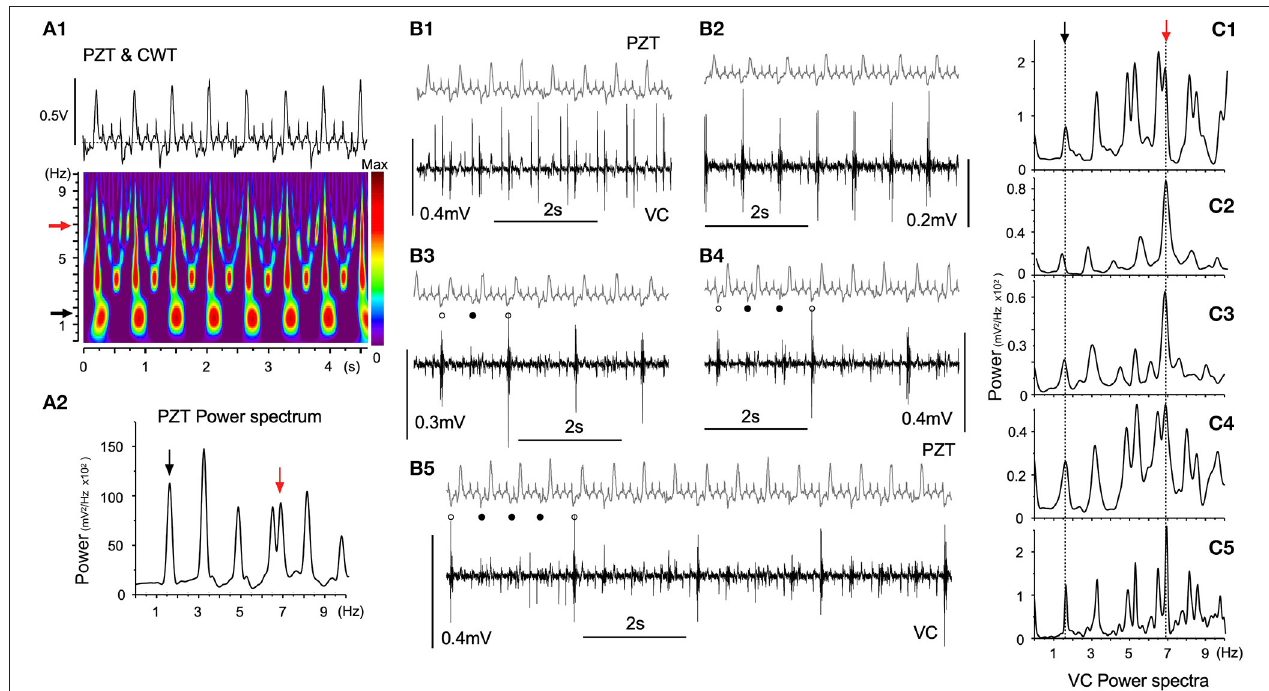
FIGURE 5 | Temporal dynamics of vagal complex (VC) neuronal activities synchronized with cardiorespiratory rhythms. (A) A piezoelectric pulse transducer (PZT) recorded cardiorespiratory rhythmic wave and the time-resolved power spectrum by the continuous wavelet transform (CWT) analysis (A1) . Respiratory (1.65Hz, black arrow) and cardiac (6.97Hz, red arrow) rhythms are shown in the CWT time-resolved power spectrum. (A2) An FFT power spectrum of PZT consists of fundamental respiratory (1.65Hz, black arrow) and cardiac (6.97Hz, red arrow) frequency peaks and several respiratory harmonic peaks. (B) Temporal phase transition of polyphasic high-amplitude potentials occurring in synchrony with every cardiac cycle (B1) , every respiratory cycle (B2) , every second respiratory cycle ( B3 , open and solid dots), every third respiratory cycle ( B4 , open and solid dots), and every fourth respiratory cycle ( B5 , open and solid dots). (C) Ten-s-duration power spectra (C1–5) corresponding to (B1–5) recordings, respectively. Arrows (black and red) indicate respiratory and cardiac frequency components corresponding to those in PZT (A2) .